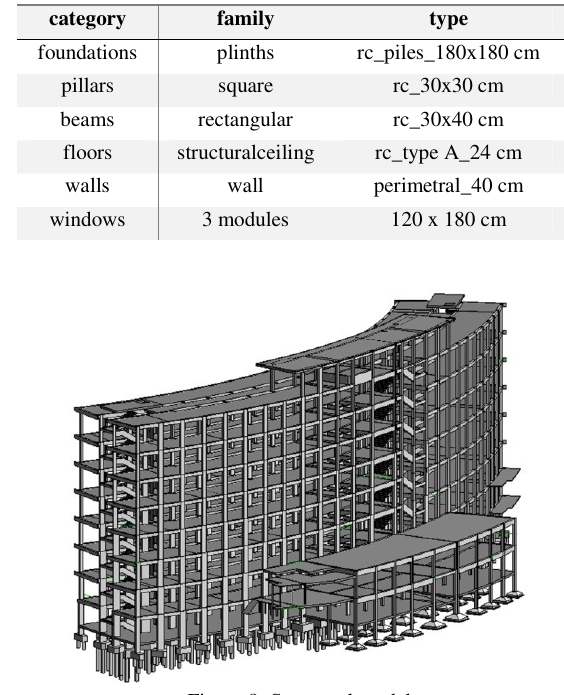
Figure 8: Structural model.